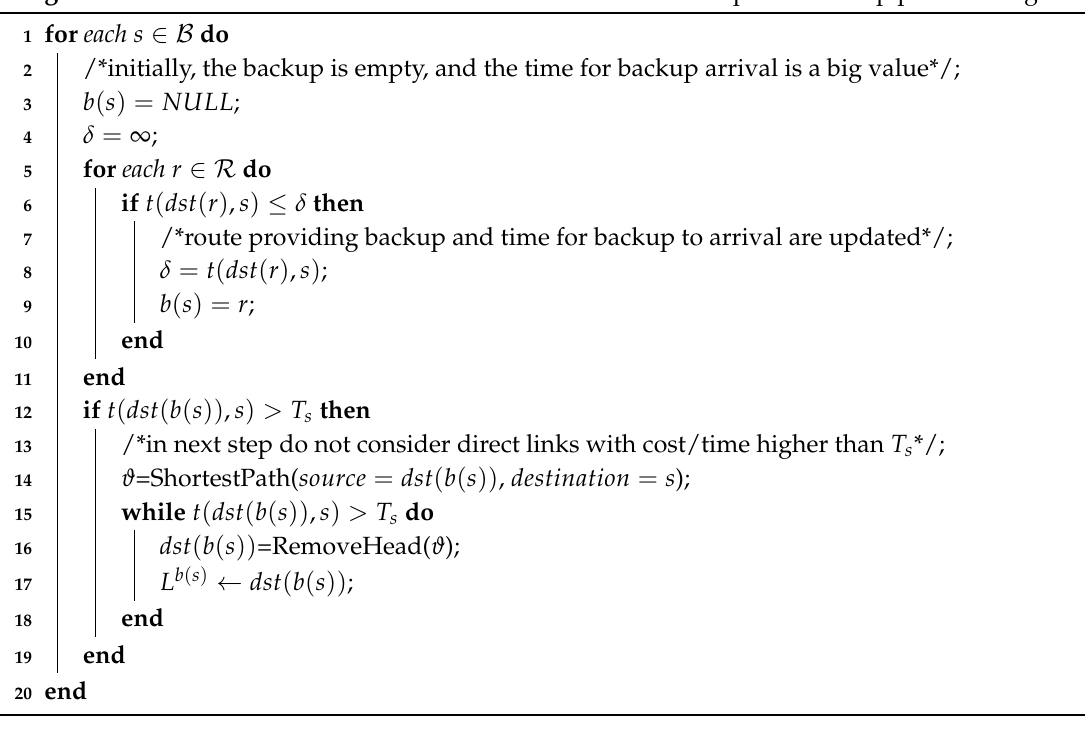
Algorithm 5: Procedure to extend the route framework and incorporate backup